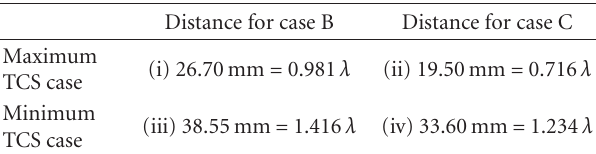
Table 1: Center-to-center distance for maximum and minimum TCS cases (cases B and C).